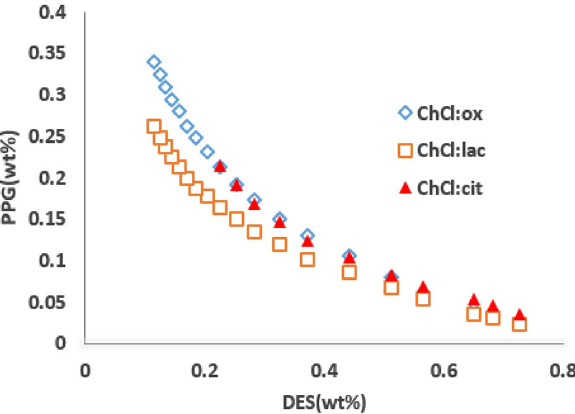
Figure 1. Experimental binodal data of ATPS composed of PPG400, mixtures of DESs and water at 298.15